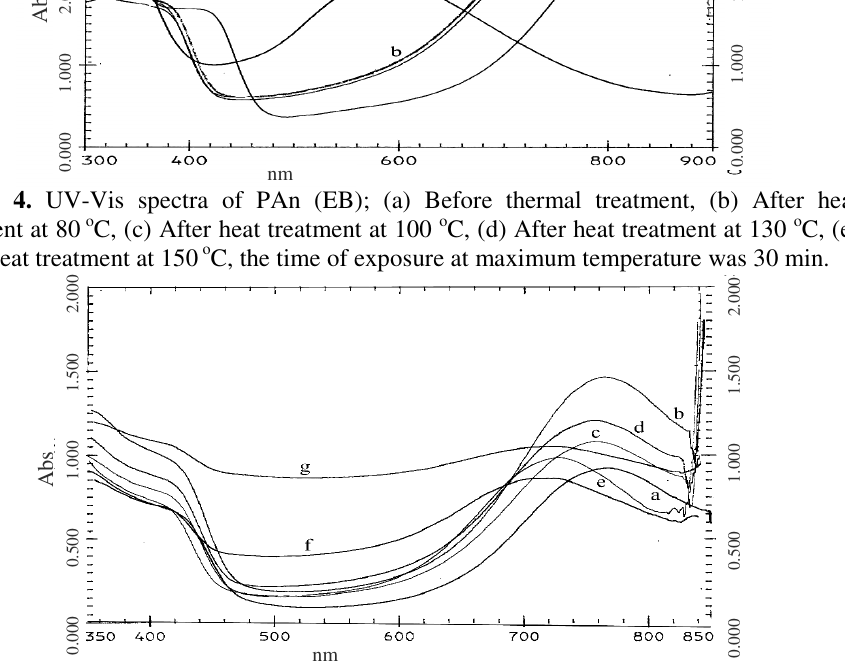
Figure 5. UV-Vis spectra of PAn (EB)/Nylon 6, (a) Before thermal treatment, (b) After heat treatment at 80 o C, (c) After treatment at 100 o C, (d) After heat treatment at 130 o C, (e)After heat treatment at 150 o C, (f) After heat treatment at 200 o C, (g) After heat treatment at 250 o C. The conditions were the same as Figure